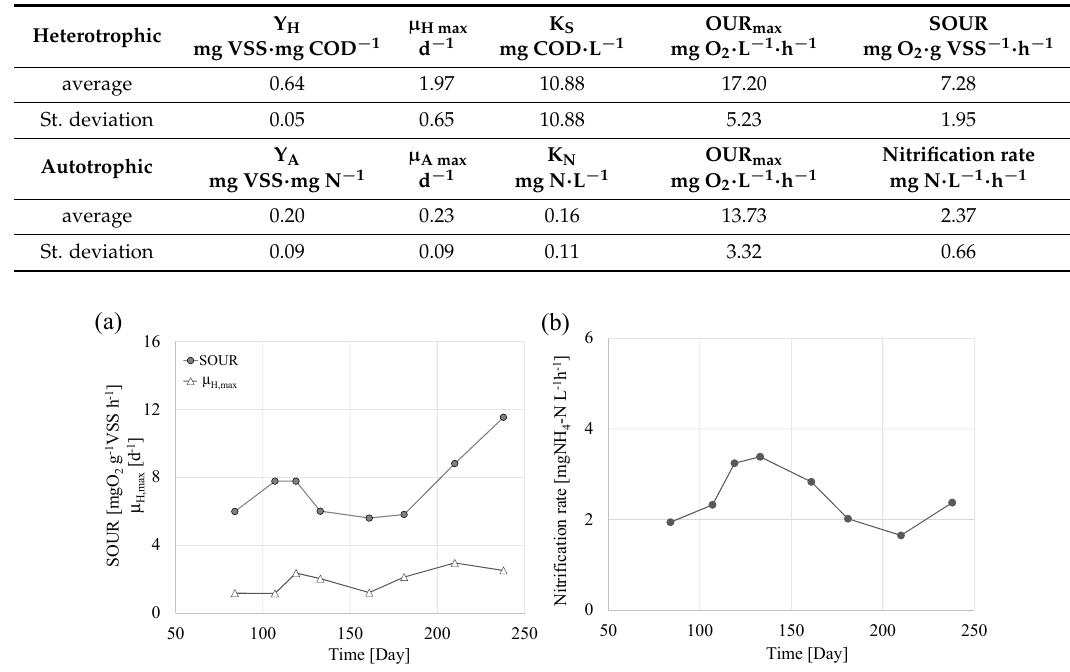
Figure 7. SOUR and maximum growth rates ( a ) for heterotrophic species and nitrification rates ( b ) for autotrophic species.